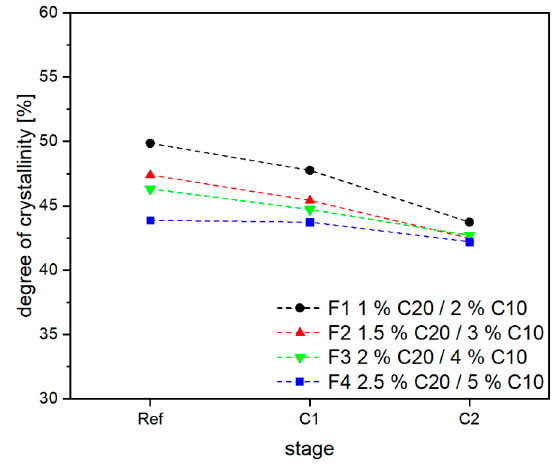
Figure 14. Degree of crystallinity of the four formulations in different stages measured with a DSC. Ricco reported a decrease of the melting temperature (Tm) with increasing residual monomer content. He states that T m is reduced by 3.5 to 5 °C per wt % monomer [14,32]. Van Rijswijk obtains a gradient of 4.3 °C in his experiments [14]. The calculation of the gradients with our unreinforced PA6 samples of stage C2 yields − 2.6 °C/wt % (F1), − 3.8 °C/wt % (F2), − 4.0 °C/wt % (F3) and − 6.0 °C/wt % (F4). With the exception of formulation F4, the values are within the interval determined by Ricco. However, it should be noted that the decrease in the melting point is also due to the decrease in the degree of crystallinity. The residual monomer content is, therefore, only an additional influence.